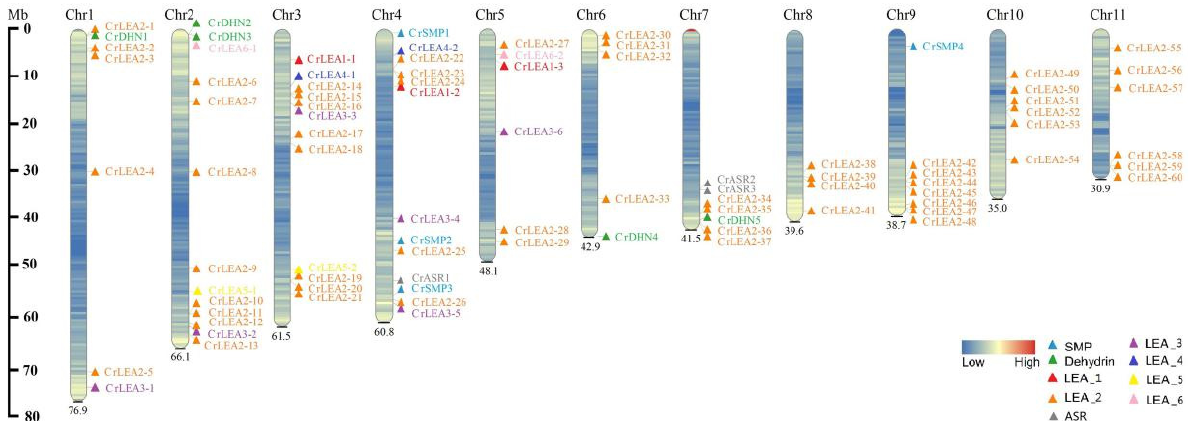
Figure 3. Chromosomal distribution of CrLEA/CrASR genes in C. rosea . Different colors showed different subfamilies, and the scale of the chromosome is in millions of bases (Mb).